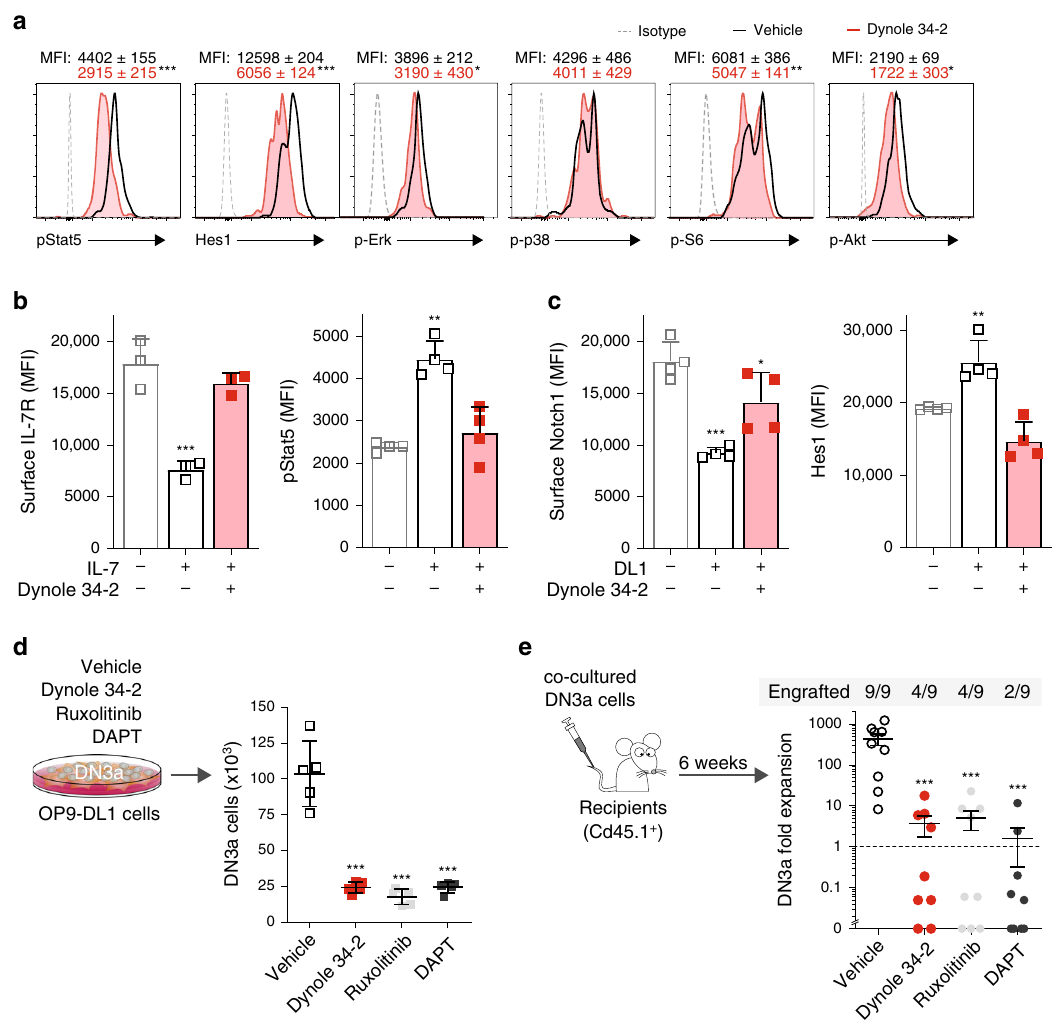
Fig. 2 Dynole 34-2 prevents the activation of the signalling network downstream of IL-7R and Notch1 in pre-leukemic DN3a thymocytes. a Levels of growth factor-mediated signalling effectors in Lmo2 Tg DN3a cells treated with vehicle or Dynole 34-2 co-cultured on OP9-DL1 with cytokines, assessed by fl ow cytometry. Mean fl uorescence intensity (MFI) ± SD of n = 4 individual animals analysed in duplicate are shown (Mann – Whitney test; * P < 0.05 and *** P < 0.001 compared to vehicle). b, Internalization assay for IL-7R (left) and downstream activation of Stat5 (pStat5; right) in Lmo2 Tg DN3a cells in steady state and after stimulation with IL-7, in presence of 0.2 μ M Dynole 34-2. MFI ± SD of n = 3 individual mice, performed in duplicate. Student ’ s t -test, ** P < 0.01, *** P < 0.001 compared to unstimulated cells. c Surface levels of Notch1 (left) and intra c ellular expression of Hes1 (right) in Lmo2 -transgenic DN3a thymocytes, co-cultured overnight on OP9 or OP9-DL1 (DL1) cells in the presence of 0.2 μ M Dynole 34-2. MFI ± SD of n = 3 individual animals, performed in duplicate. Student ’ s t -test * P < 0.05, ** P < 0.01, *** P < 0.001 compared to OP9 (unstimulated) controls. d , e Absolute numbers of co-cultured Lmo2 Tg DN3a thymocytes treated in vitro with either vehicle, Dynole 34-2 (0.2 μ M), Ruxolitinib (0.2 μ M) and DAPT (0.1 μ M) for 72 h ( d ), and in vivo fold expansion of these cells measured 6 weeks post-transplantation in the thymus of recipients ( e ). Mean ± SD, Student ’ s t -test ( N = 4 individual mice). *** P < 0.001 compared to v e hicle. Number of recipients engrafted is